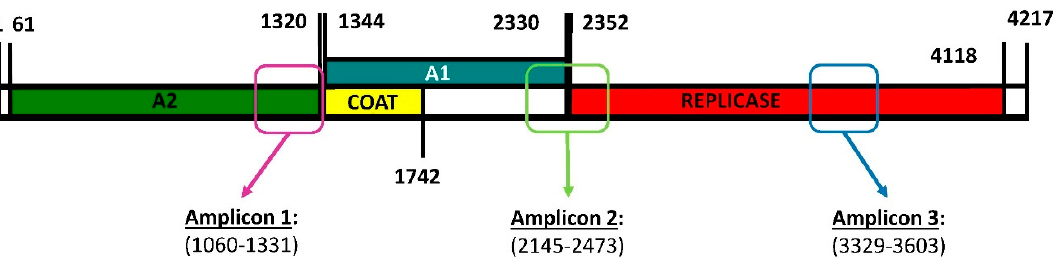
Figure 1. Genome map of bacteriophage Q β showing the encoded proteins and the regions subjected to deep sequencing. A2 is the maturation protein involved in the internalisation of the viral genome and the exit of the mature viral particles. The coat protein is the major capsid protein that can sometimes be extended, giving rise to a minor capsid protein denoted A1. The replicase is the protein that copies the RNA genome. Primers used to generate the amplicons shown in the figure are described in Section 4.